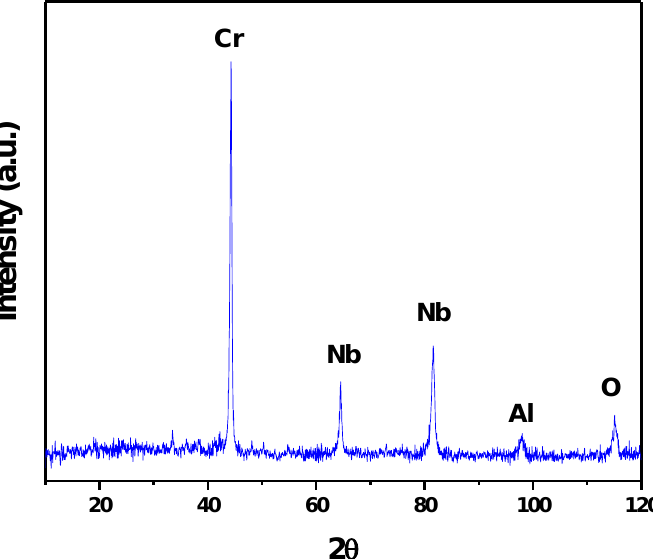
Figure 3. XRD analysis at 20 h of milling.